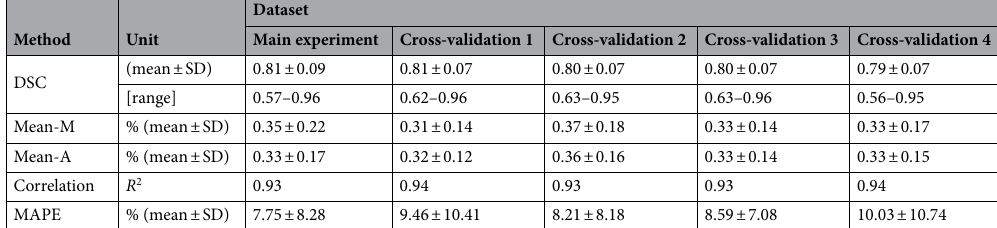
Table 2. Cross-validation results for parotid %ID. DSC dice similarity coefficient, M manual segmentation, A automatic segmentation, MAPE mean absolute percentage error.